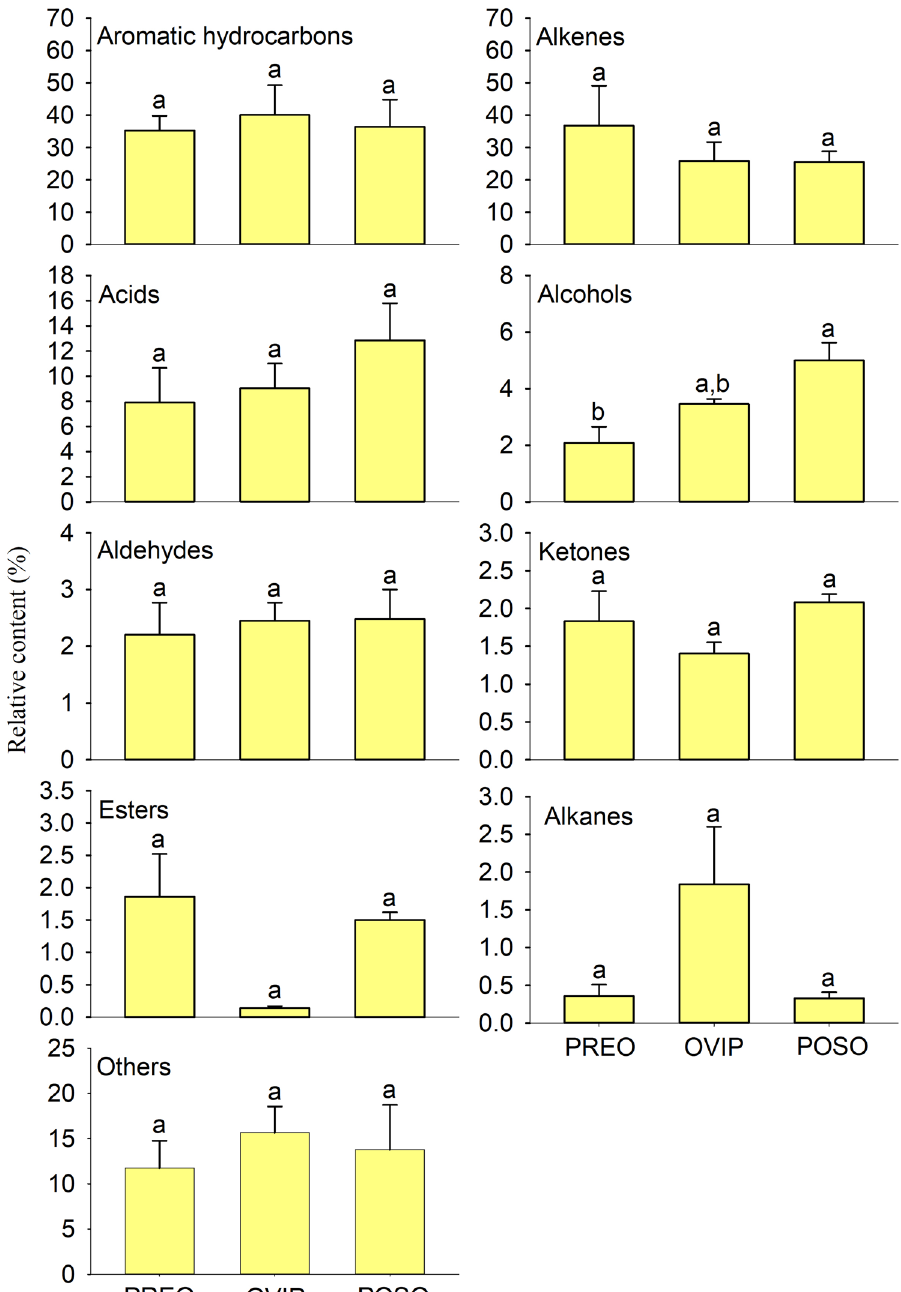
Figure 1. Volatile classes detected from fresh feces of Przewalski’s horse at the stages of PREO, OVIP, and POSO of Gasterophilus pecorum. PREO, OVIP, and POSO represent fresh feces at the stages of pre-oviposition, oviposition, and post-oviposition of Gasterophilus pecorum , respectively. Data are mean (n = 3) ± SE. Different letters indicate significant differences at P <